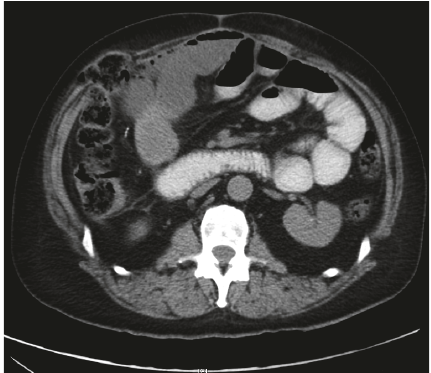
Figure 5: ST elevations in leads II, III, aVF, V5, and V6 (case